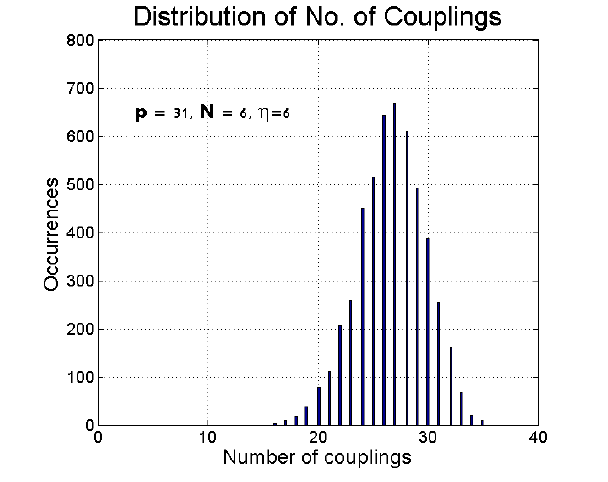
Figure 7. Distribution of the number of couplings for p = 31 , N = 6 , η = 6 .